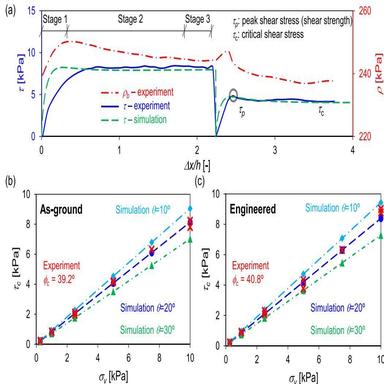
Shear behavior from the Schulze ring shear test. (a) A typical shear response where numerical (green dashed line) and experimental (blue line) shear stress τ, as well as experimental bulk density ρ (red dot-dashed line) are plotted versus strain Δx/h for the as-ground sample. The applied vertical stress σv at the pre-shear step and the second step is 10 kPa, and 5 kPa, respectively. The peak shear stress (shear strength) τp and critical state shear stress τc are obtained. (b-c) The relation of the critical